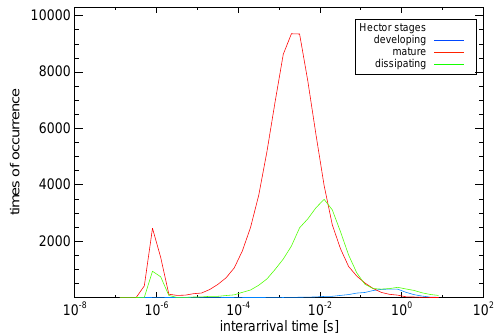
Figure 1. Frequency distributions of interarrival times used to iden- tify shattering artefacts in the CIP image data. The data are grouped into Hector classification stages as described in Sect.